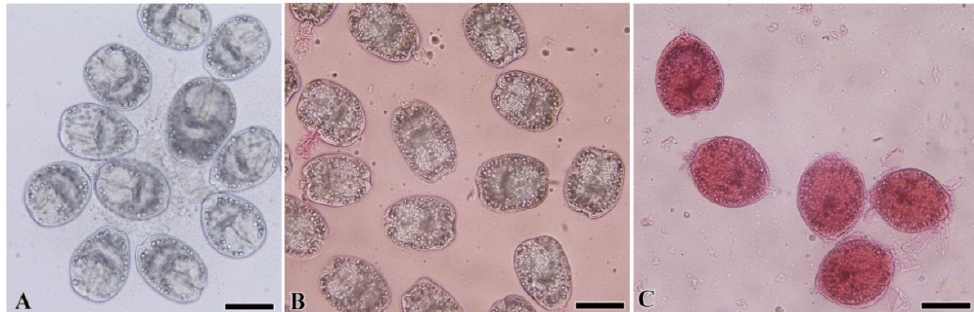
Figure 4. Live non-stained protoscolices ( A ), live protoscolices after staining with 0.1% eosin ( B ), dead protoscolices after treatment with L. steochas EO and staining with 0.1% eosin ( C ). Scale-bar = 100 mm.